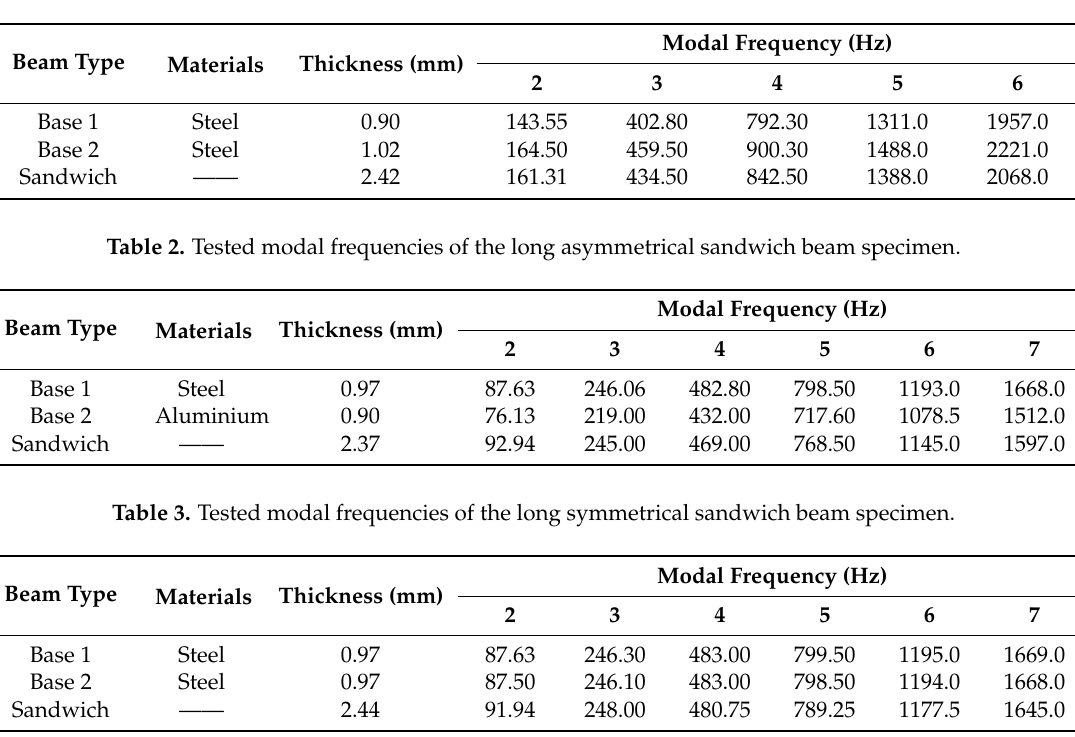
Table 1. Tested modal frequencies of the short asymmetrical sandwich beam specimen.